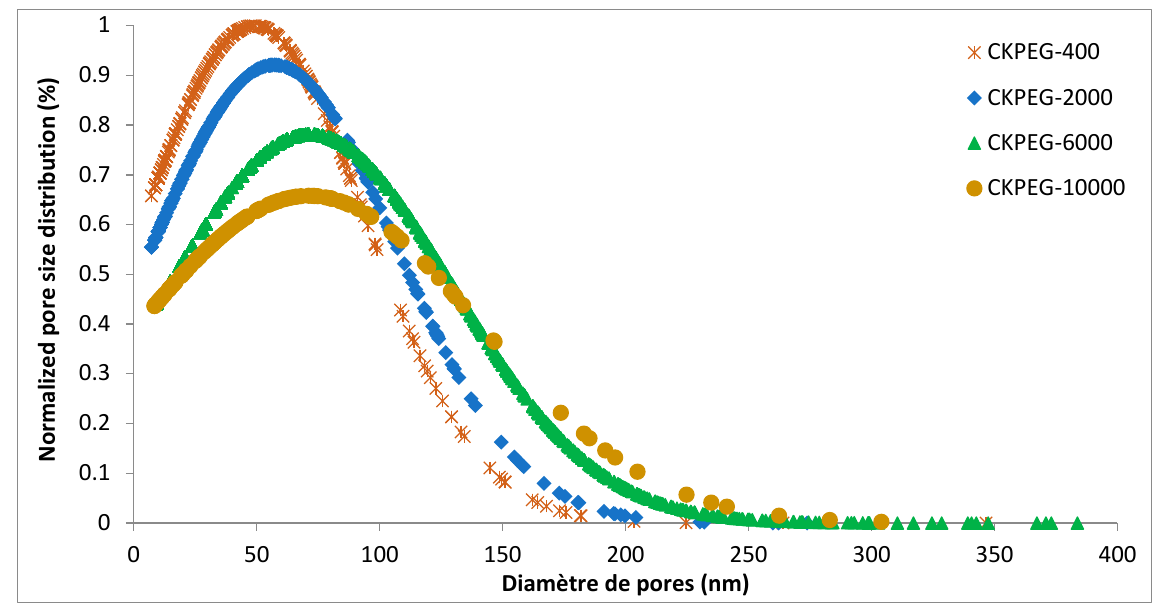
Figure 6. Pore size distribution determined using image analysis of SEM images depicting the surface of composite membranes prepared with varying PEG Mw as pore formers.